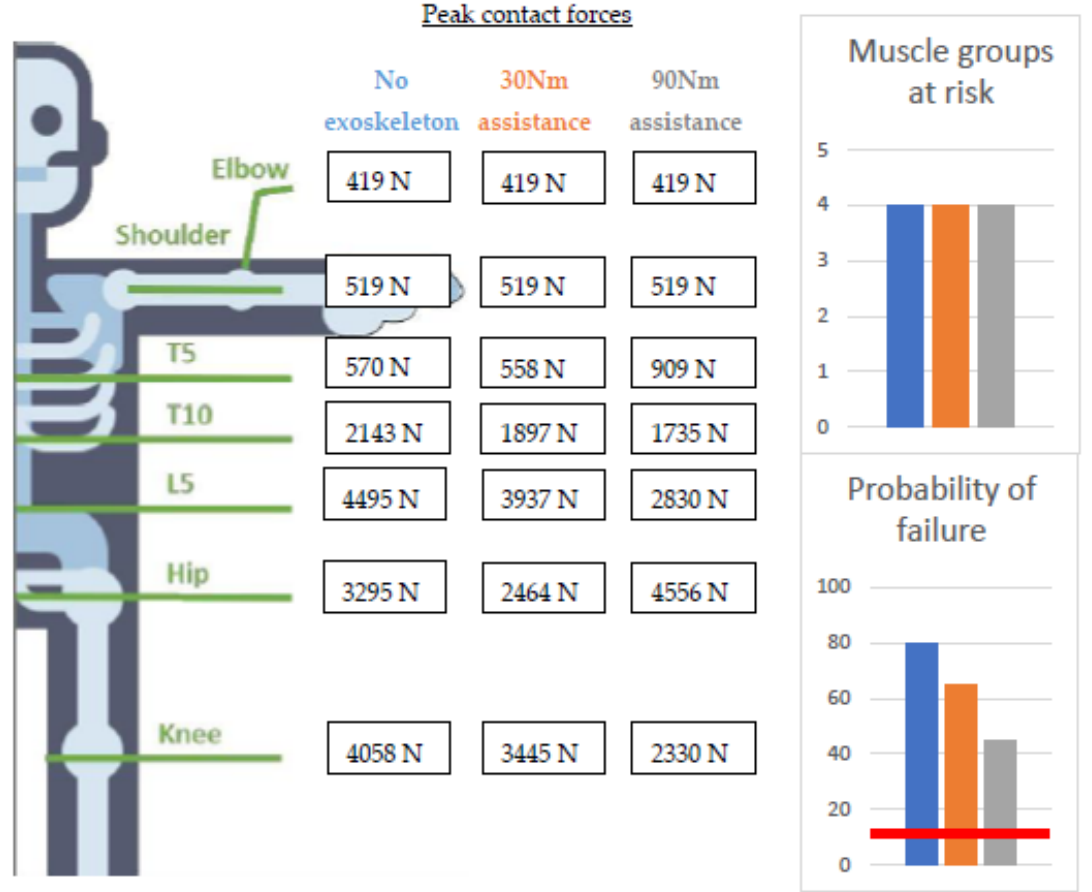
Figure 5. Peak joint contact forces in the different joints calculated with the musculoskeletal-modeling workflow and compared with the different tissue-specific injury thresholds implemented in the MATE for the back exoskeletons. Values above the red line are high risk.